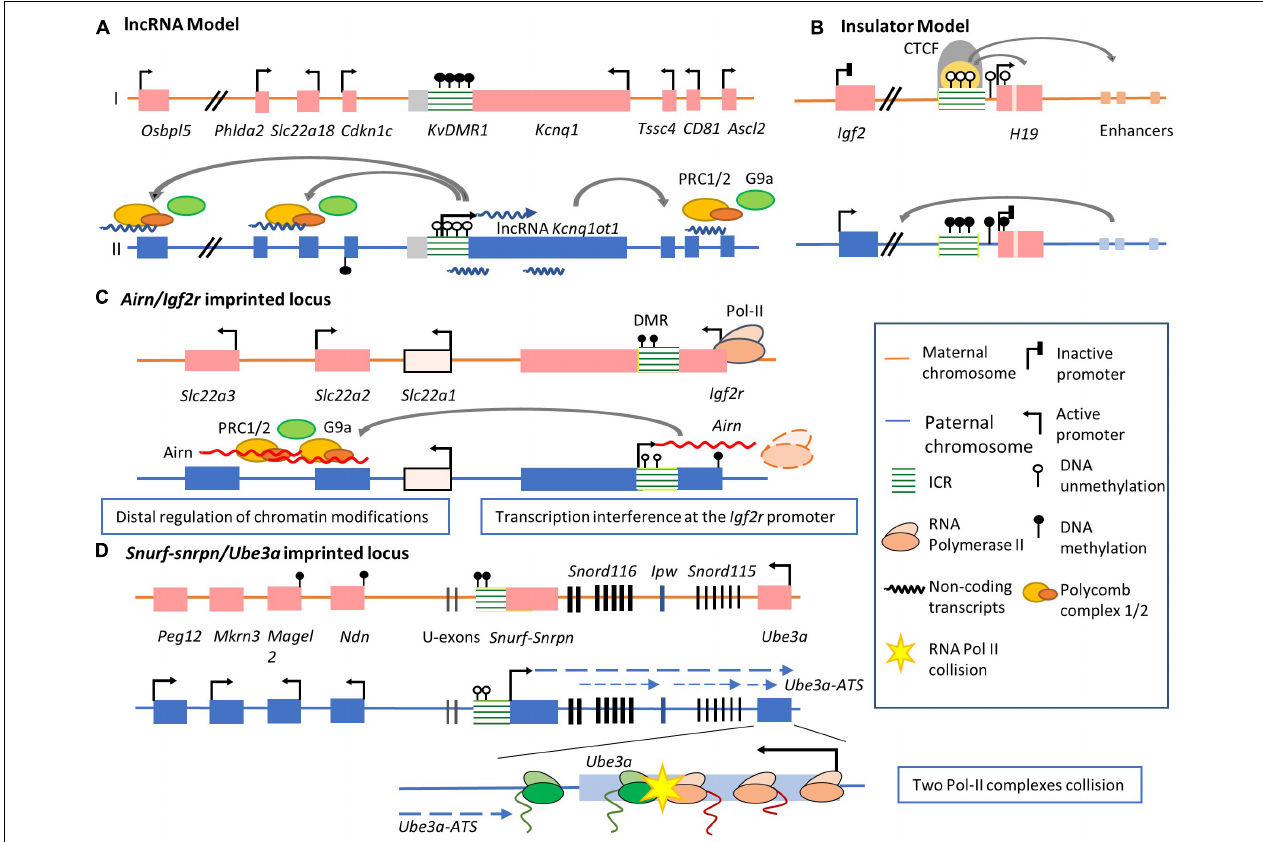
FIGURE 2 | Mechanisms by which imprinted lncRNA regulate allelic expression in imprinted clusters. (A) The lncRNA model of imprinted gene expression regulation. In Kcnq1ot1 imprinted cluster, the ICR is unmethylated on the paternal allele, permitting lncRNA Kcnq1ot1 expression. The expression of this lncRNA recruits the PRC1/2 complex and histone methyltransferase G9a, leading to condensed chromatin and silencing of flanking protein-coding genes. The ICR is methylated on the maternal allele, inhibiting lncRNA expression. The expression of Kcnq1 and several paternal silenced genes are activated. (B) The insulator model of imprinted gene expression regulation. The ICR on the maternal allele is unmethylated. CTCF binds to the maternal ICR and functions as an insulator to block Igf2 access to its distal enhancers. In contrast, the ICR on the paternal allele is methylated, preventing binding of CTCF. The expression of Igf2 is activated via enhancer regulation. (C) lncRNA Airn in Airn/Igf2r locus function in two distinctive mechanisms. On the one hand, methylated DMR on the maternal allele inhibits Airn expression, allowing access of transcription factors to the Igf2r promoter. The paternal DMR is unmethylated, permitting Airn transcription. Airn overlaps with the promoter of Igf2r and inhibits Igf2r expression. On the other hand, Airn transcripts recruit PRC2 complex to distal genes, such as Slc22a3 and Slc22a2 , where they silence expression. Slc22a1 is a biallelic expressed protein-coding gene between distal regulated imprinted genes and Igf2r gene loci. (D) In Snurf- Snrpn/Ube3a imprinted cluster, the transcription of Ube3a-ATS starts from the exon upstream of the Snurf-Snrpn gene on the paternal allele. A group of non-coding RNAs are expressed, including Snord116 and Snord115 sno-lncRNAs and SnoRNAs. The elongation of this lncRNA overlaps with the Ube3a protein-coding region. A collision occurs between the converging elongation complexes of Ube3a-ATS and Ube3a resulting in the failure of Ube3a transcription elongation. By contrast, on the maternal allele, the ICR of Snurf-Snrpn / Ube3a cluster is methylated in the brain. G9a is recruited to the methylated DMR. This G9a accumulation leads to condensed chromatin and the silencing of flanking imprinted genes near the Snurf/Snrpn gene region. Consequently, the maternal Ube3a allele is